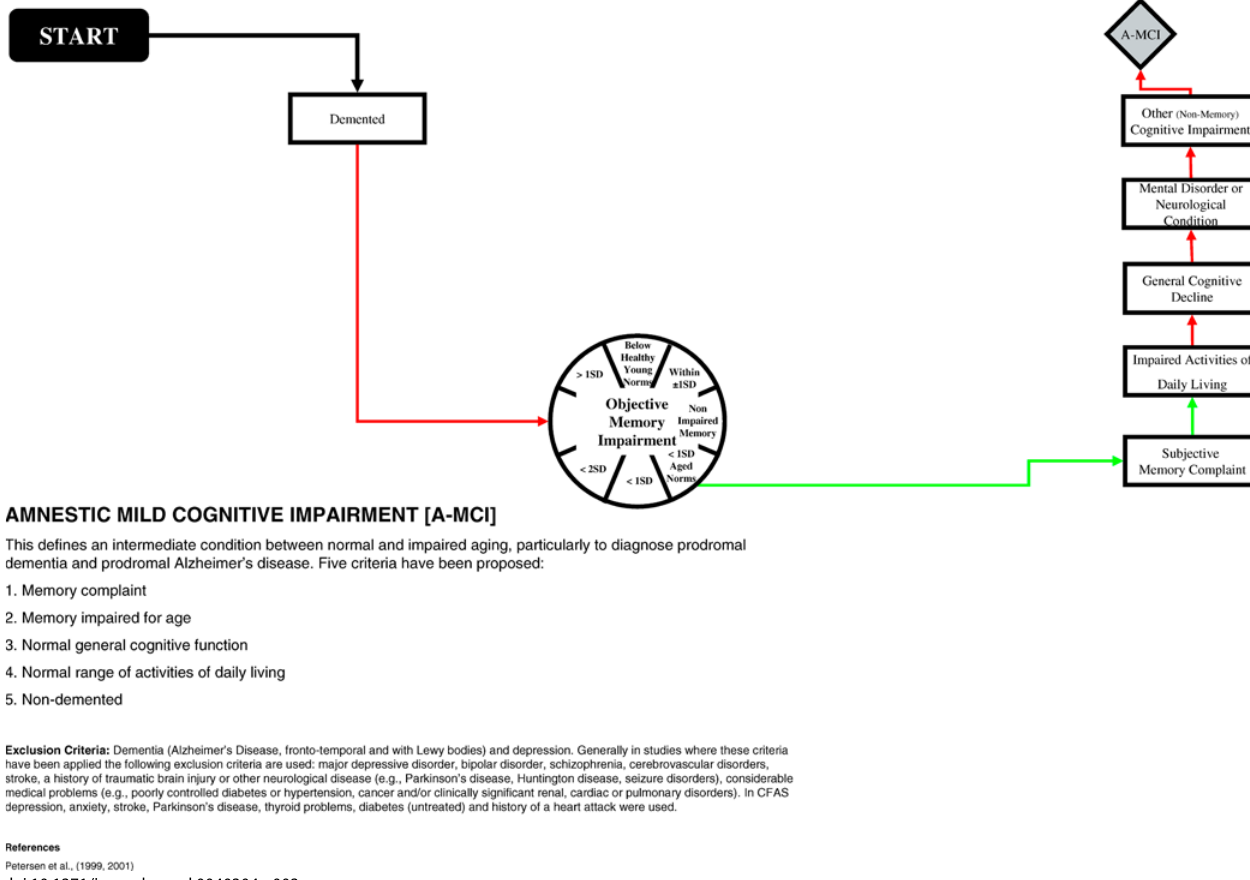
Figure 3. Operationalisation of Amnestic Mild Cognitive Impairment in the Medical Research Council Cognitive Function and Ageing Study SD, standard